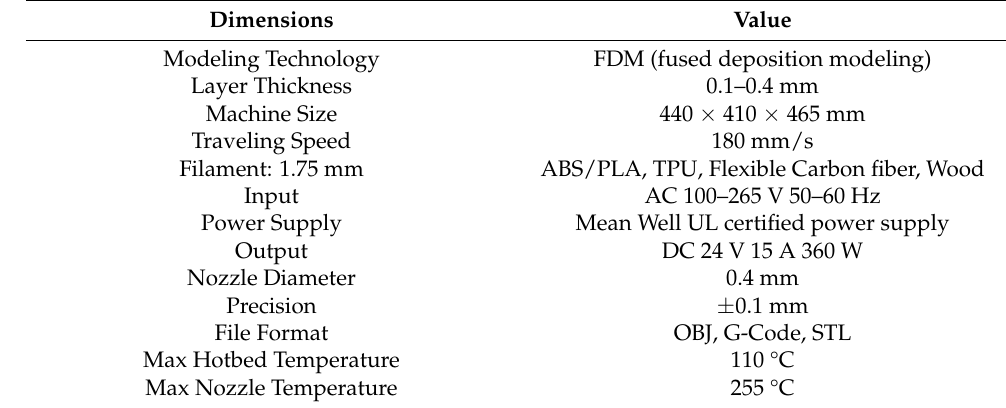
Table 2. Ender 3 Pro